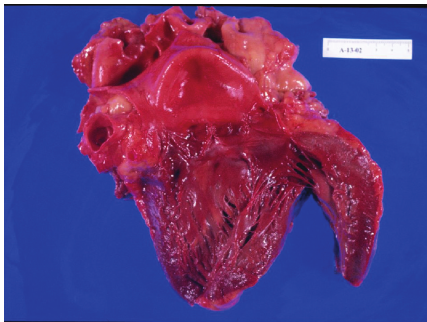
Figure 3: Heart specimen showing acute subendocardial- myocardial